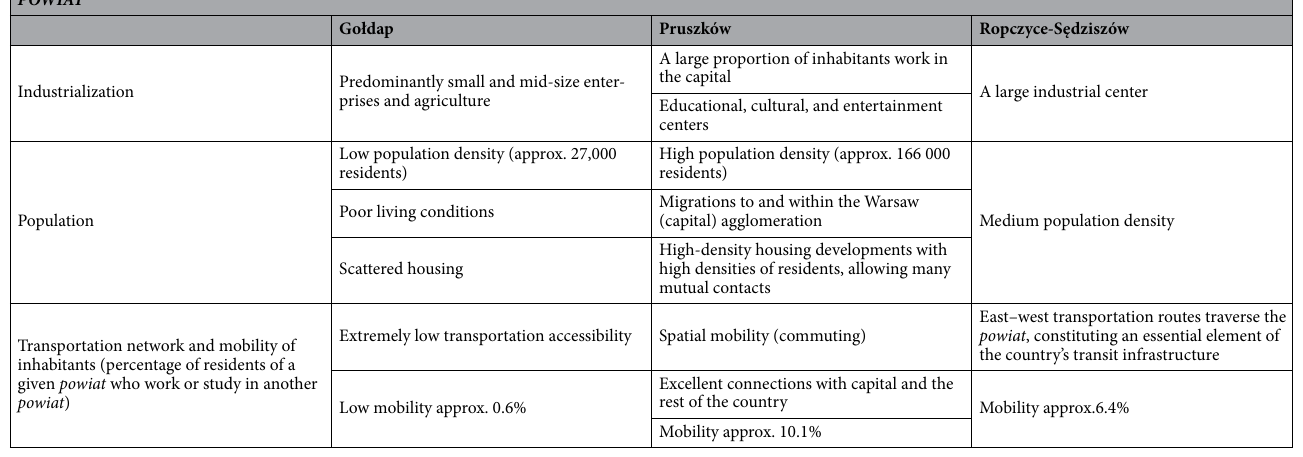
Table 1. Description of selected test